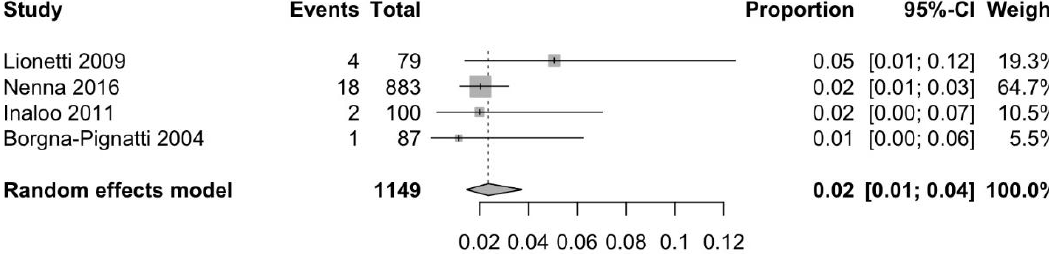
Figure 5. Pooled mean prevalence of coeliac disease in children with idiopathic headache.